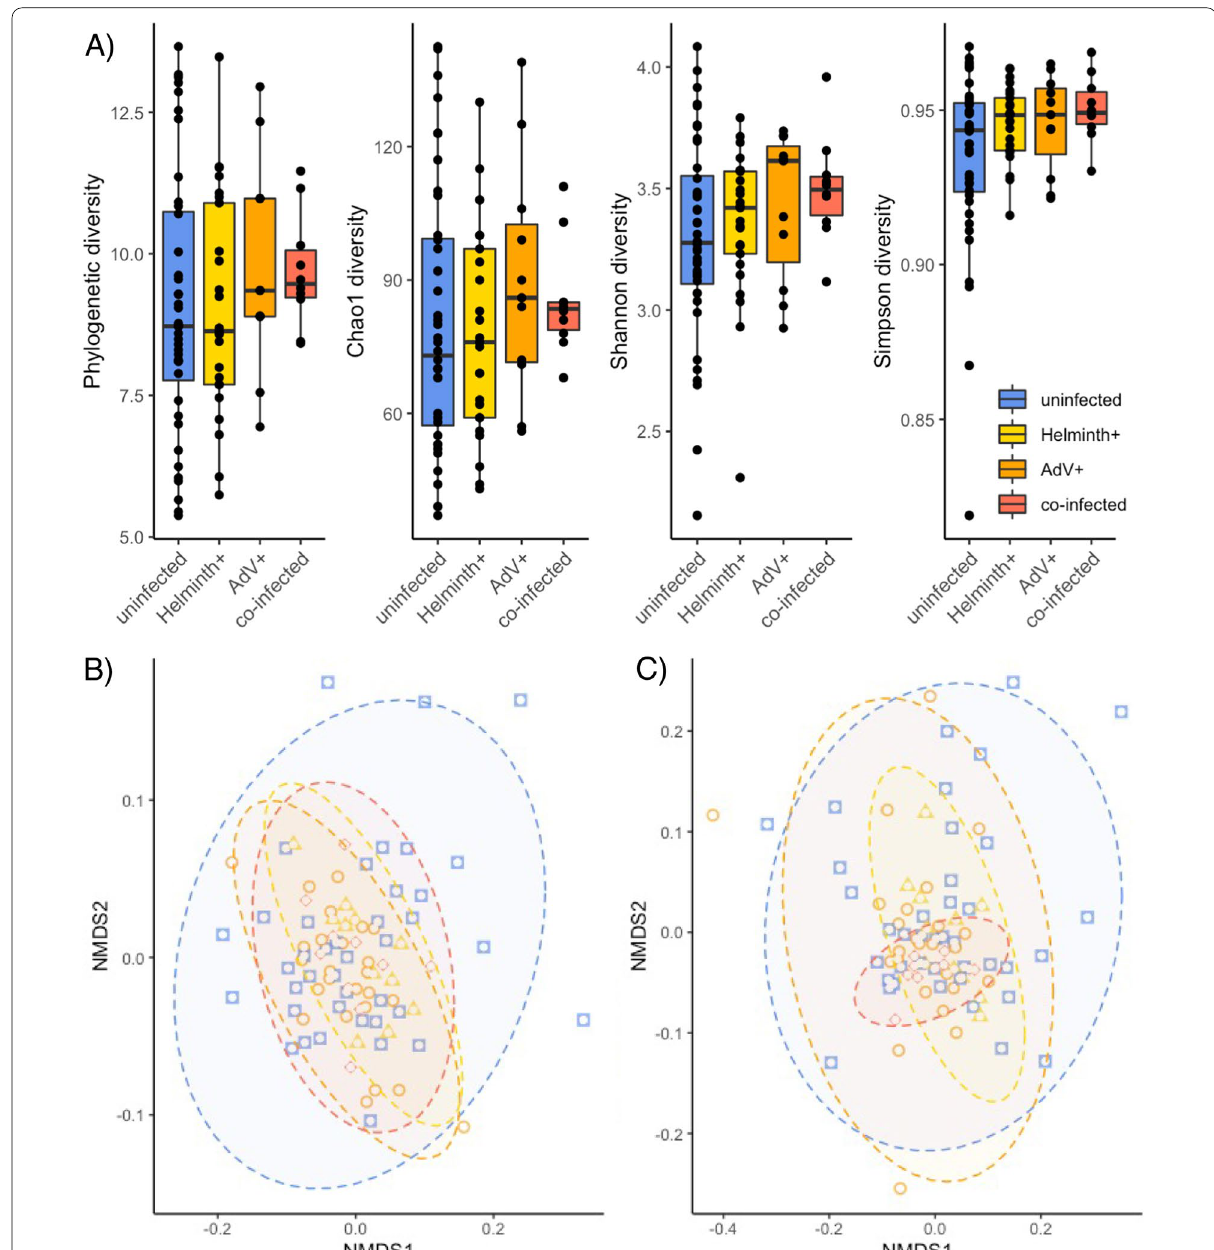
Fig. 3 Differences in gut microbial α- and ß - diversity in uninfected, single-infected and co-infected mouse lemurs ( M. griseorufus ). A α-diversity measured by Faith’s phylogenetic diversity, Chao1, Shannon diversity, Simpson (left to right) and B ß - diversity measured by weighted and C unweighted UniFrac distances and illustrated by non-metric multi-dimensional (NMDS) ordination plots. Displayed are uninfected (blue squares), single-infected (helminth + : yellow triangle, AdV + : orange circles) and co-infected (red diamonds) mouse